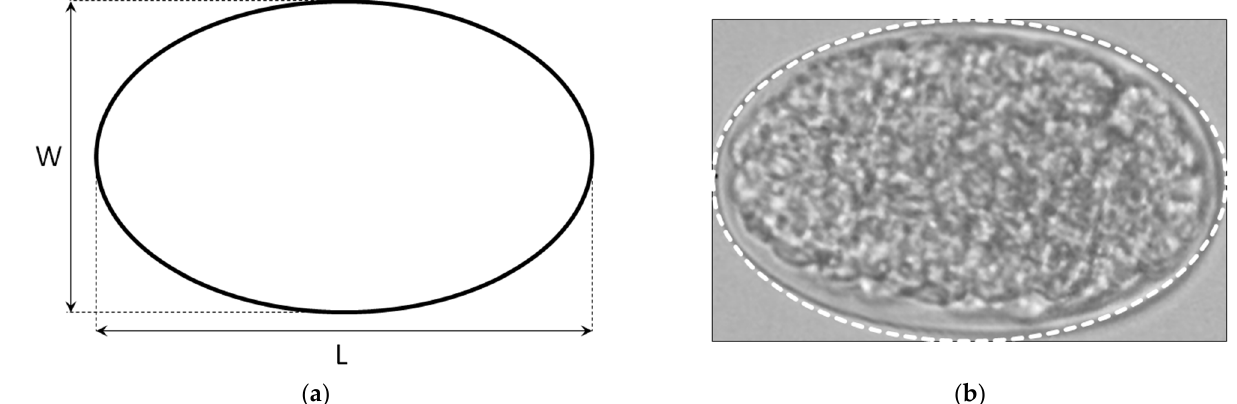
Figure 2. OES, ( a ) idealized elliptic shape, ( b ) idealized shape compared with real shape.